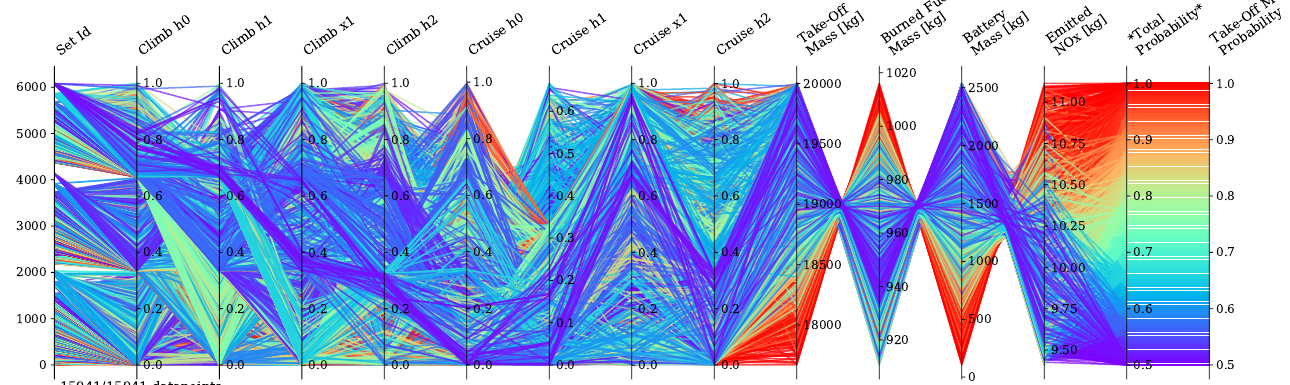
Figure 6. Data of Experiment